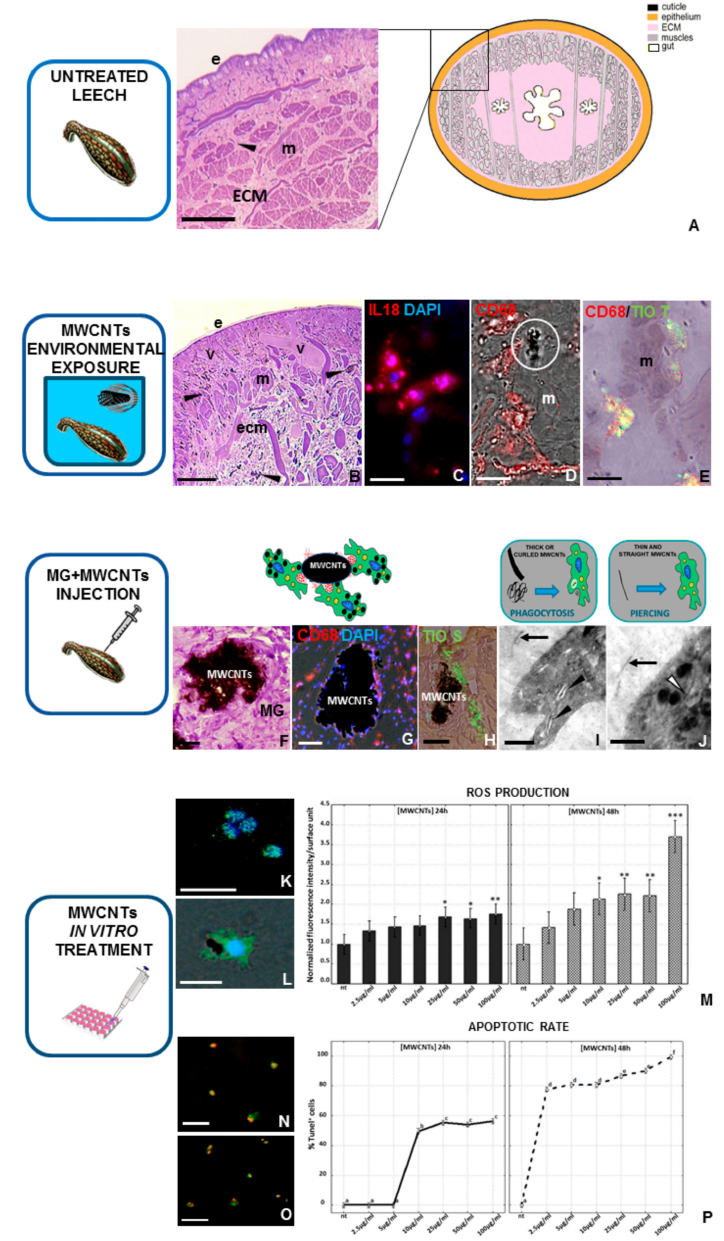
Figure 3. E ff ects of MWCNT treatment on leech tissues and cultured macrophages. ( A ) Schematic representation and image taken via optical microscope of the cross-sectioned body wall of an untreated leech. Underneath the cuticle and epithelium (e), only a few resident immunocompetent cells (arrow), dispersed in a loose connective (ECM) and predominantly avascular tissue, were detectable around the muscle fibers (m). After MWCNT environmental exposure ( B – E ), several new vessels (v) and numerous migrating cells are localized under the epithelium (e) and among muscle fibers (m).